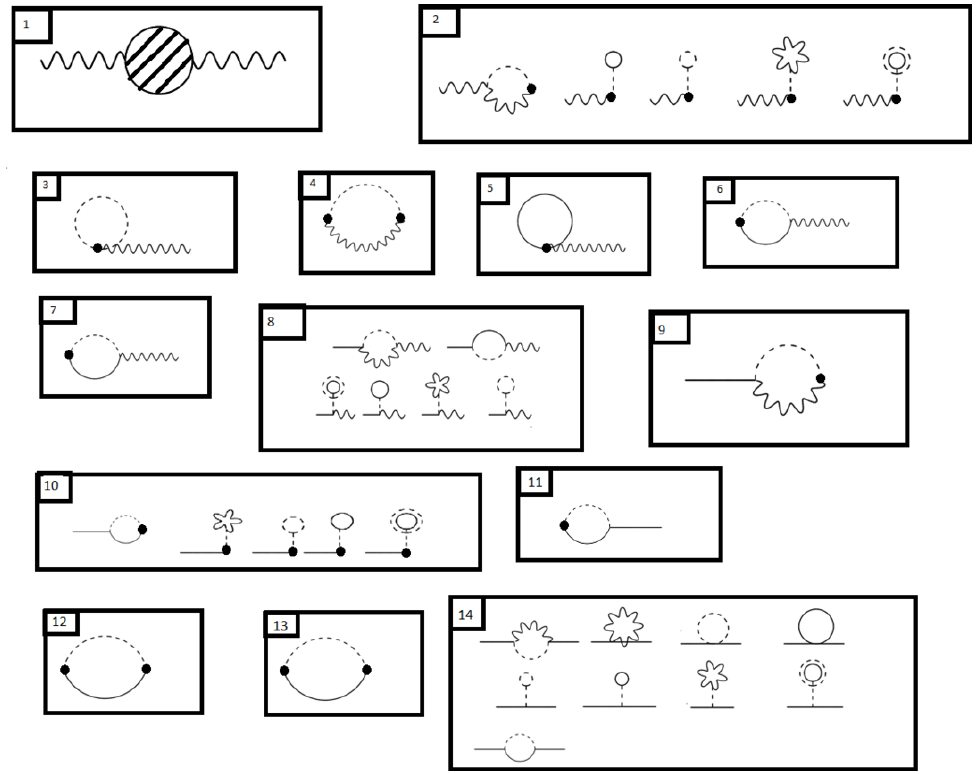
Figure 16 . One-loop contributions for the propagator h V (cid:22) ( p ) V (cid:23) ( (cid:0) p ) i . Wavy lines represent the photon (cid:12)eld, dashed lines the Higgs (cid:12)eld, solid lines the Goldstone boson and double lines the ghost (cid:12)eld. The (cid:15) indicates the insertion of a composite